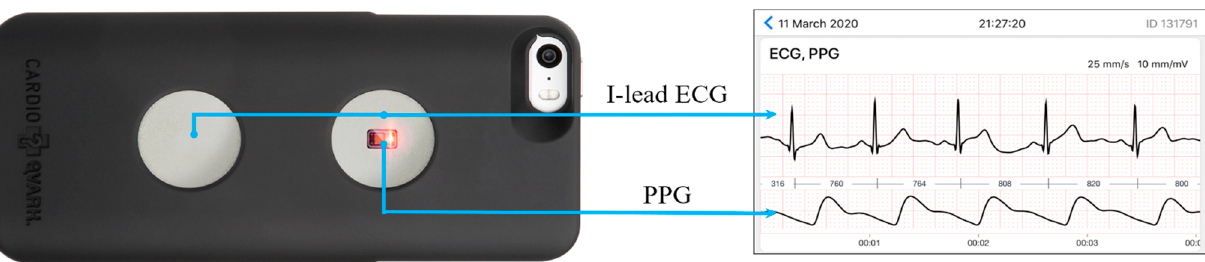
Figure 1. Characteristics of CardioQVARK device. On the left side , there is the electrode for I-lead ECG registration and on the right side the monitor for photoplethysmography PPG. The device is shown together with an example of the presentation of the recording.